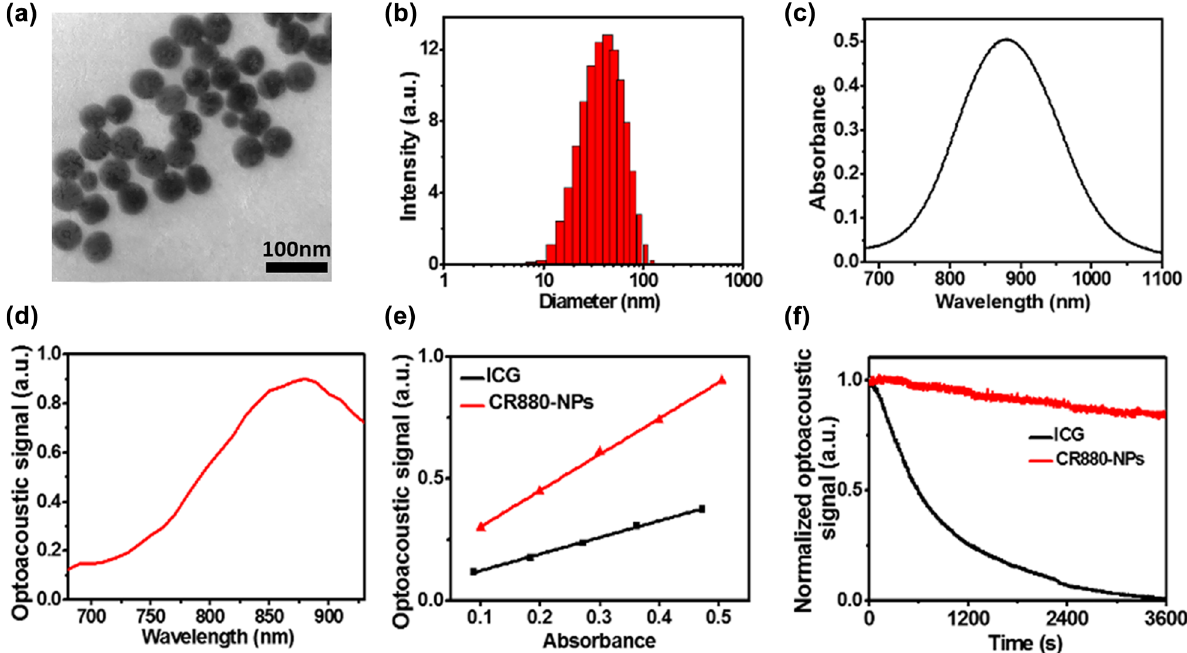
Figure 1: Physical characterization of CR880-NPs. The synthesized CR880-NPs as assessed by (a) transmission electron microscopy, (b) dynamic light scattering, (c) an optical spectrum obtained by spectrometry, and (d) an optoacoustic spectrum obtained by MSOT. (e) Optoacoustic signals of ICG and CR880-NPs at different concentrations, with the optoacoustic generation efficiency (OGE) indicated. (f) Optoacoustic signal degradation of ICG and CR880-NPs after pulsed laser irradiation (fluence ∼ 10 mJ/cm 2 , 60